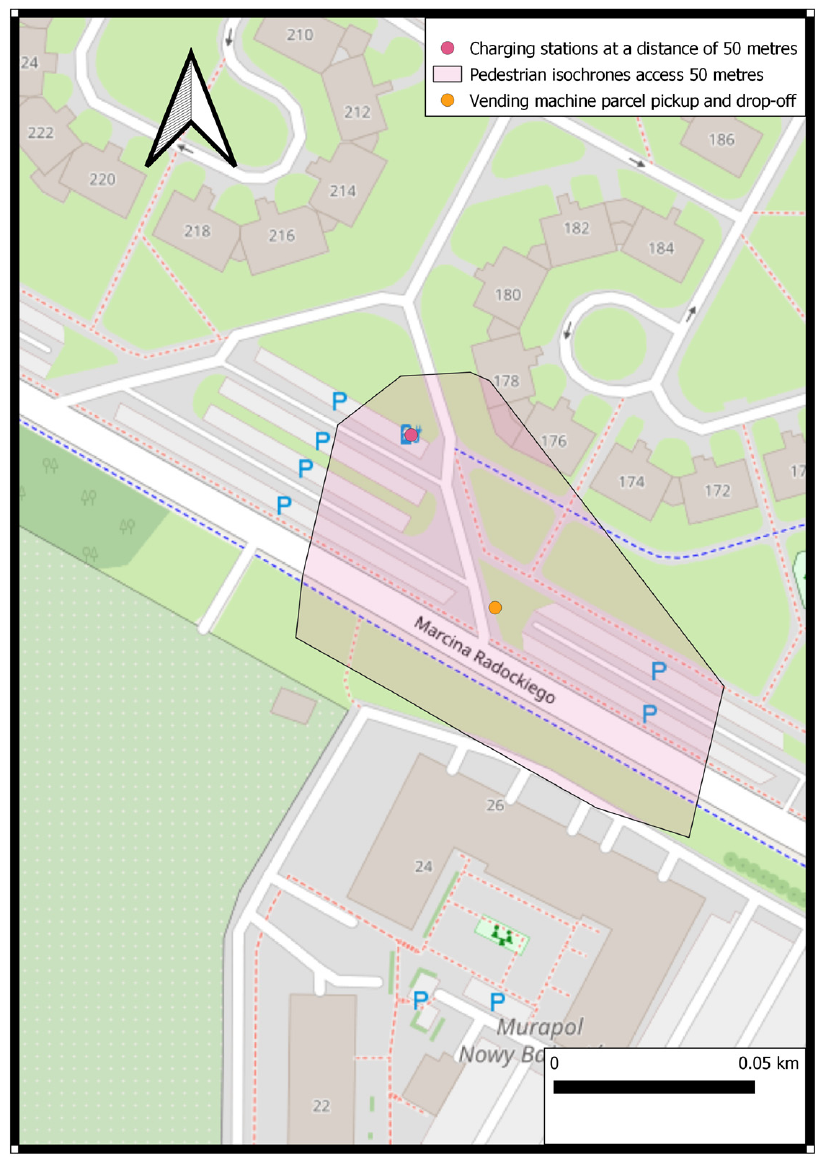
Figure 5. Detailed presentation of one charging station within a distance of less than 50 m from a parcel pick-up and drop-off parcel pick-up and drop-off point.